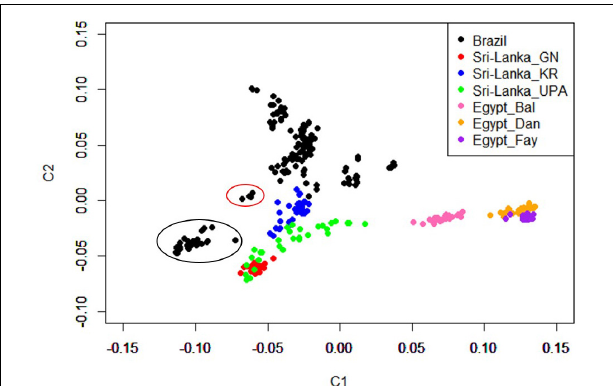
FIGURE 1 | Multi-dimensional scaling (MDS) plot showing distinct sampling populations from three countries; Brazil, Sri Lanka, and Egypt. MDS plot was constructed using genomic distances to examine population stratification. The Cochinchina and Brahma Brazil breeds (black circled) and Sedosa (red circled) clustered separate and away from the rest of the eight Brazilian breeds/ecotypes.